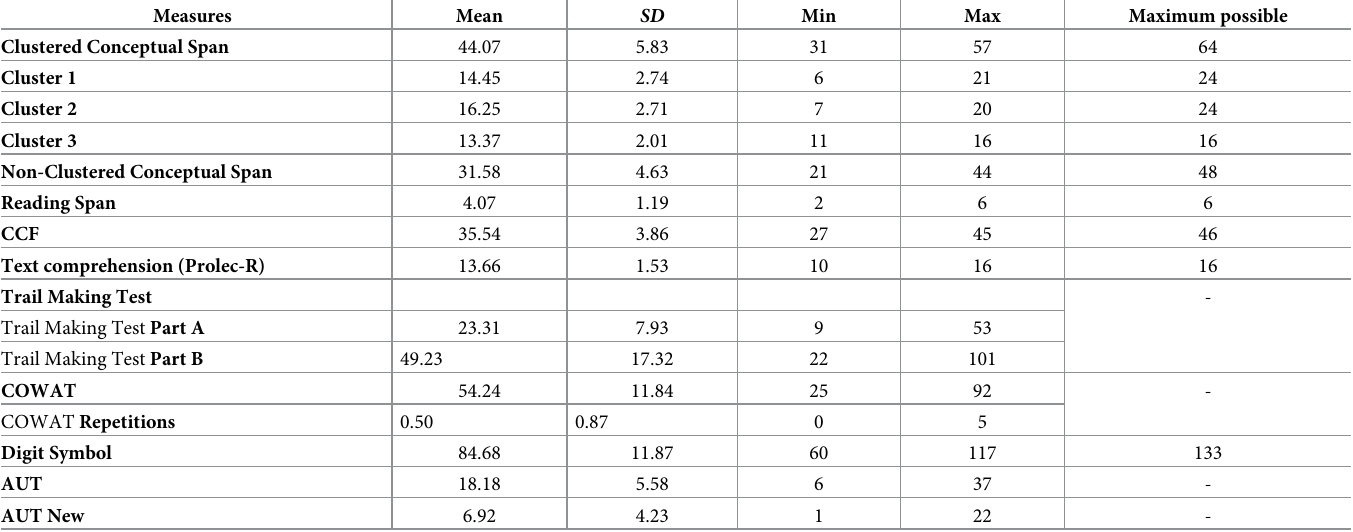
Table 5. Mean performance on the measures employed in Study